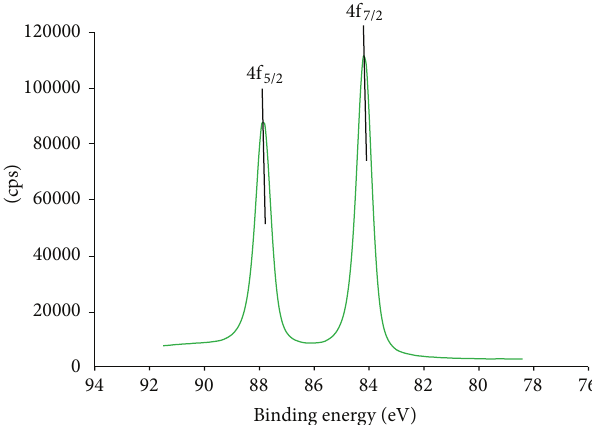
Figure 3: XPS analysis of bare (Au) QCM sensor. XPS core-level spectrum of Au4f for the Au (bare) QCM